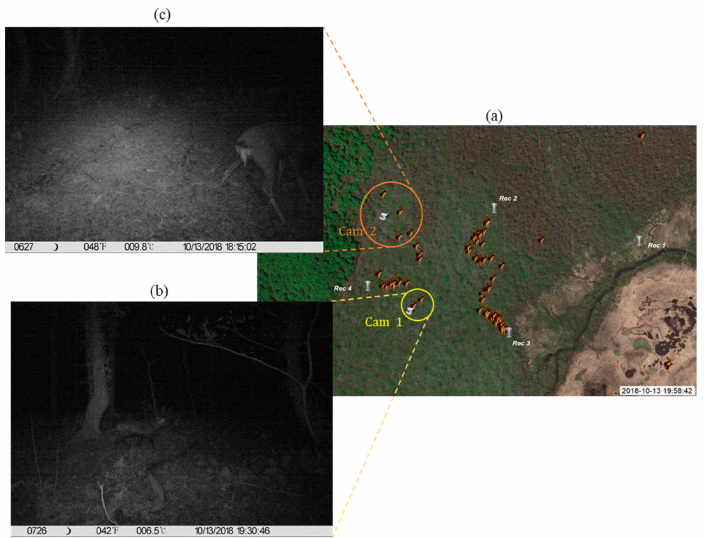
Figure 10. ( a ) Shows the deer call positions retrieved between 18:00 to 20:00 on 13 October 2018 using the proposed technique, along with locations of two camera traps. The deer captured by camera traps 1 and 2 are shown in ( b , c ),